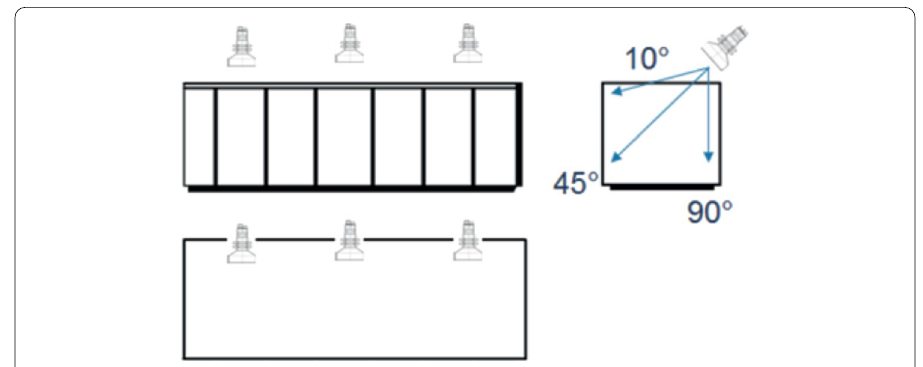
Fig. 6 Placement of ultrasonic sensors. Source: